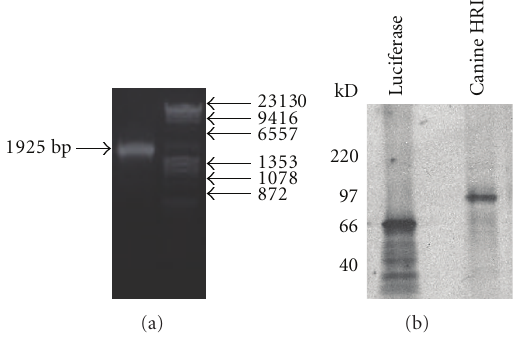
Figure 2: (a) Restriction digestion analysis of the canine-HRI- containing pcDNA4 plasmid DNA verifies the canine HRI was inserted into the NotI and EcoRI restriction sites. Digested frag- ments were separated by agarose gel electrophoresis (0.8%) and found to have a size of 1925 bp. (b) Canine HRI expressed by TNT using a Promega Wheat Germ Lysate kit. Lane 1 shows the [ 35 S]- luciferase control and Lane 2 shows the expression of [ 35 S]-canine HRI. The molecular weight markers are shown to the left of the